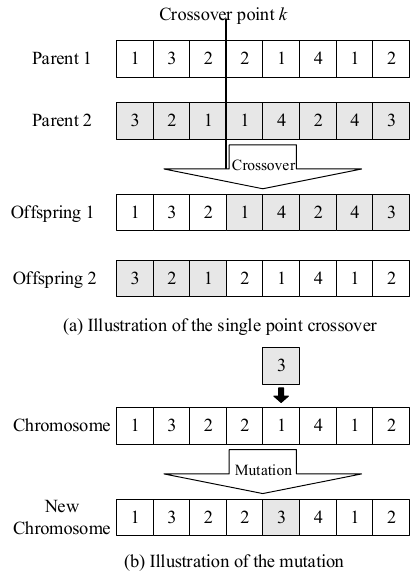
Figure 3. The illustration of the crossover and mutation operators.